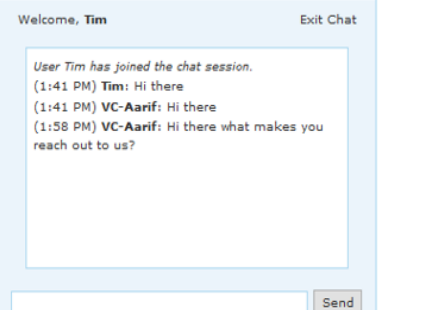
Figure 18. Client screen showing the response from Counsellor